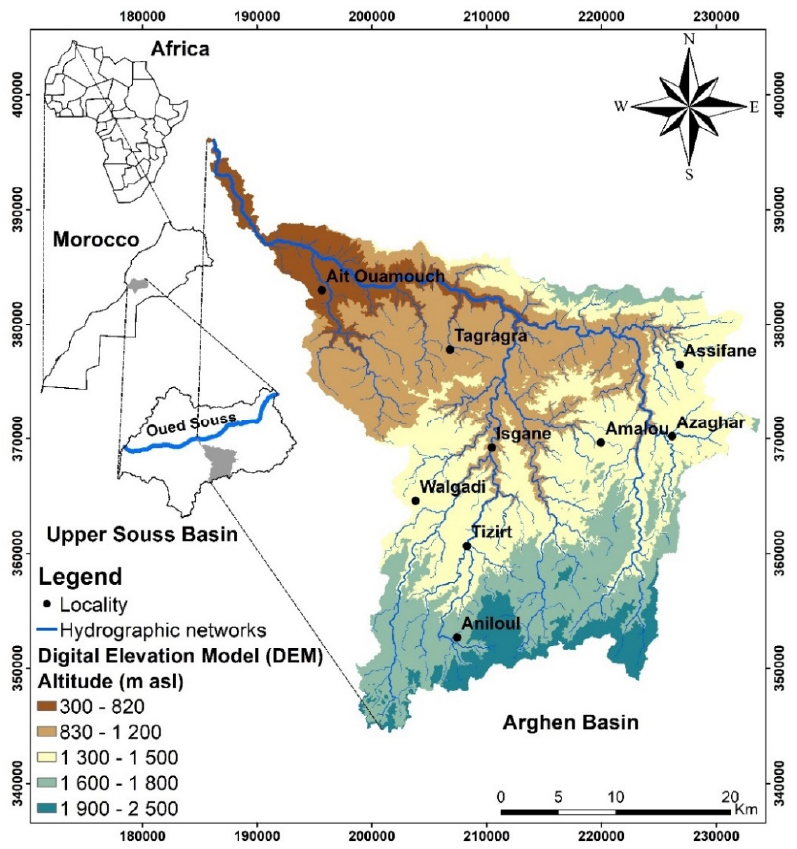
Figure 1. Geographic situation of Arghen basin.